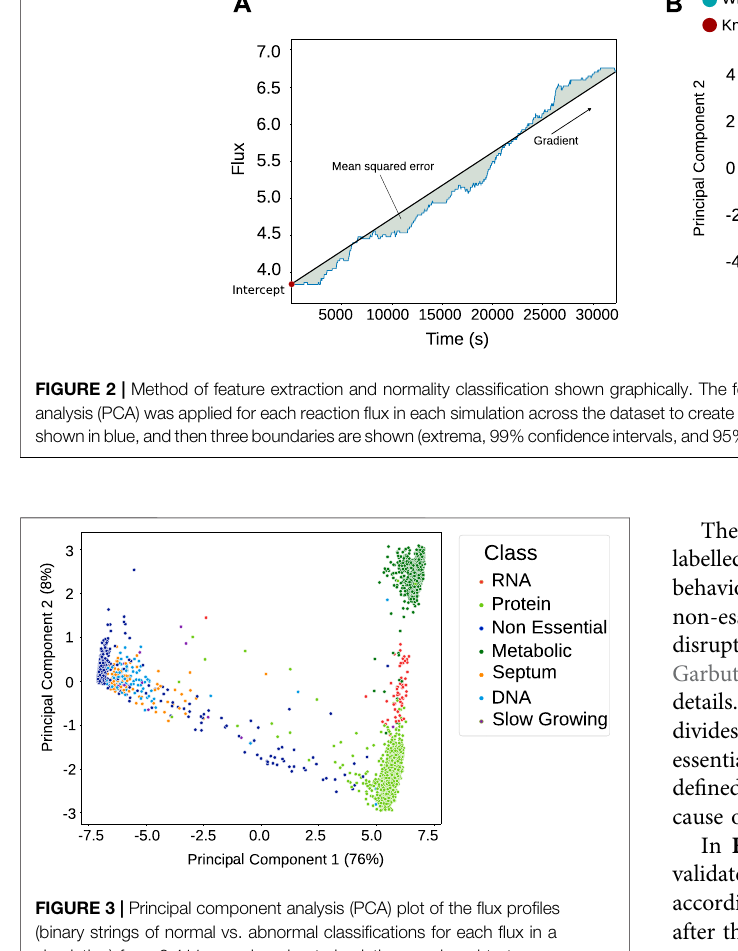
pro fi le ” for each simulation: a binary string for each reaction within that simulation, where 0 means normal behaviours and 1 means abnormal. Reactions for neural networks with less than 70% accuracy were removed (of which there were 12 in total), leaving 267 reactions with a mean accuracy of 93.6%. We applied PCA to reduce the fl ux pro fi les to two dimensions while retaining most of the variance and visualised, as shown in Figure 3 . Each point is the fl ux pro fi le of a simulation, and the principal components correspond to the reduced dimensions of the reaction fl ux pro fi les. As PCA preserves global and pairwise distances between all data points, unlike other dimensionality reduction processes that focus on local distance (such as t-Distributed Stochastic Neighbor Embedding (Van der Maaten and Hinton, 2008) and Uniform Manifold Approximation and Projection (McInnes et al., 2018)), this enables us to see not only the relationship between data points but the relationship between the different clusters, leading to clearer interpretability.